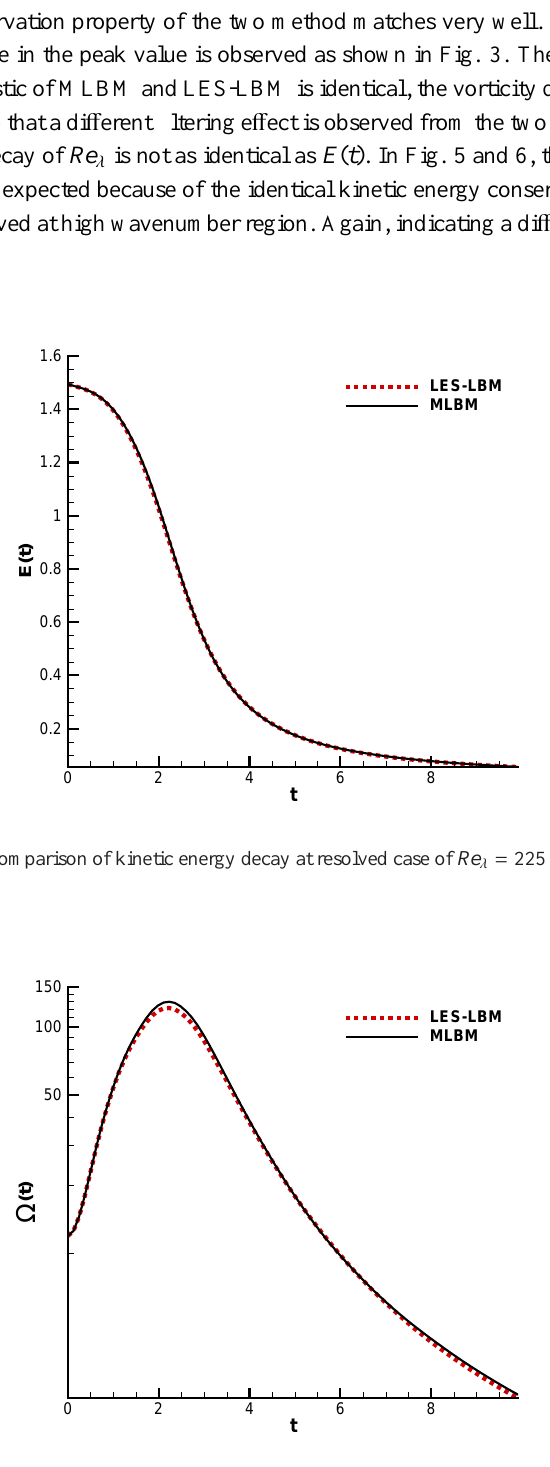
Fig. 3 Comparison of enstrophy at resolved case of Re λ = 225 at mesh 256 3